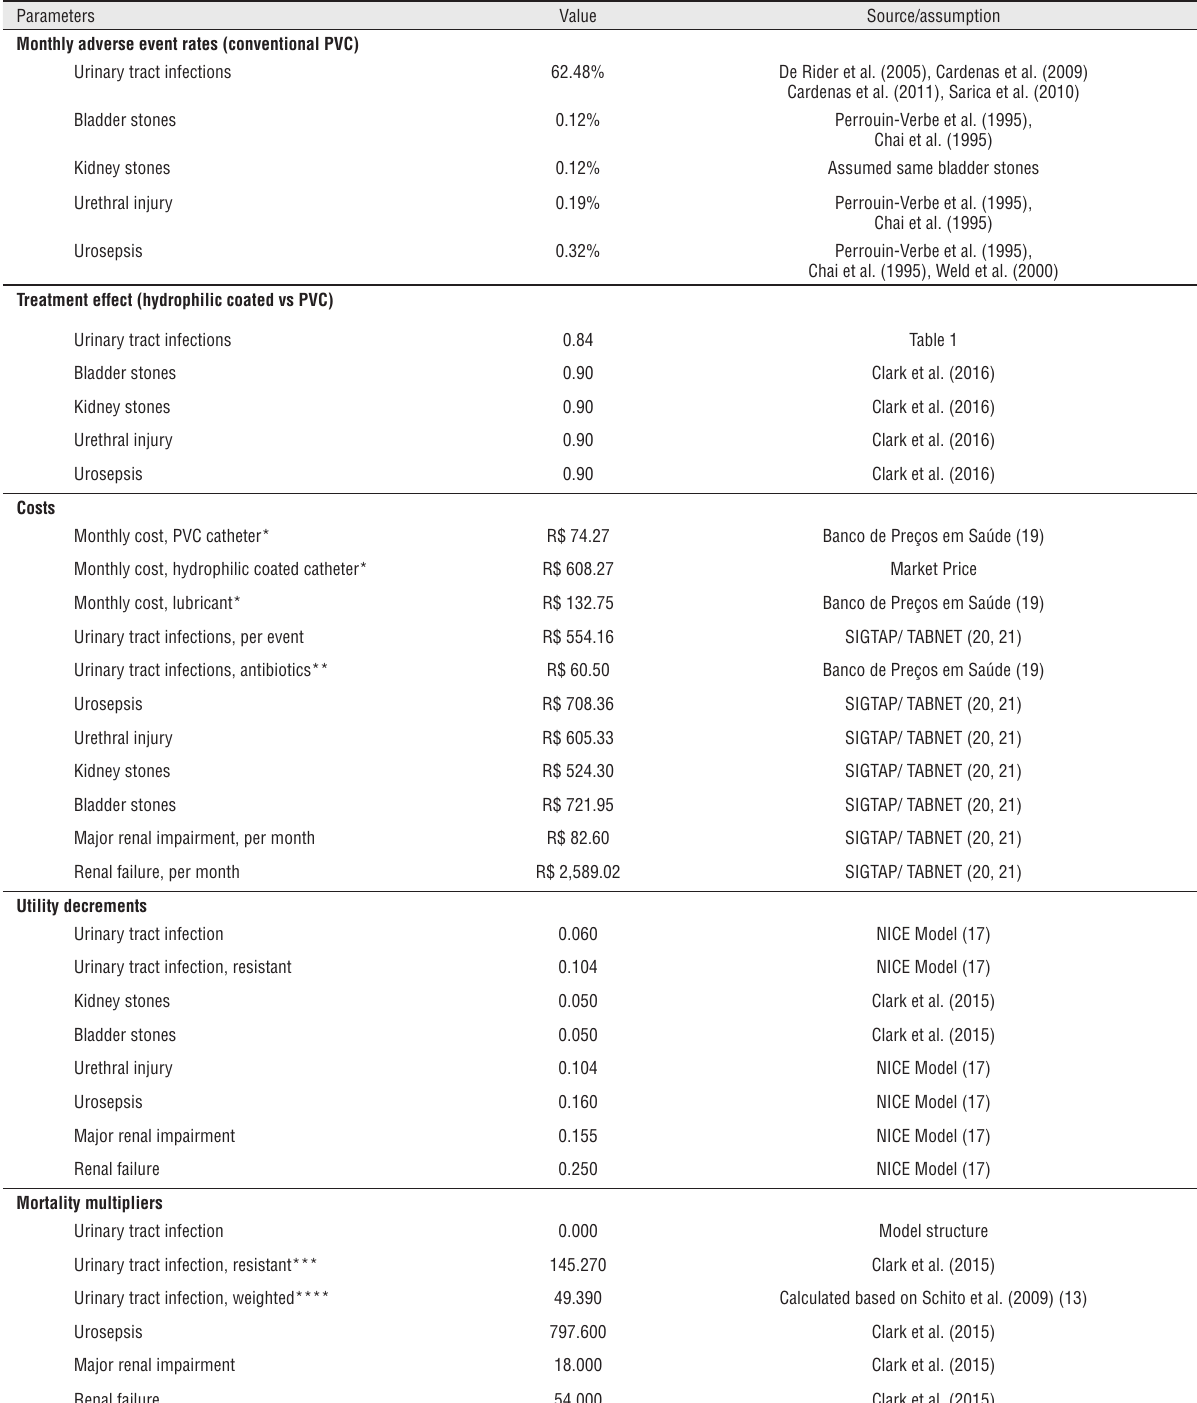
Table 2 - Key input